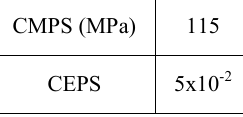
Table 1. Best set of (CMPS,CEPS) pair for the RT-PMMA under consideration.